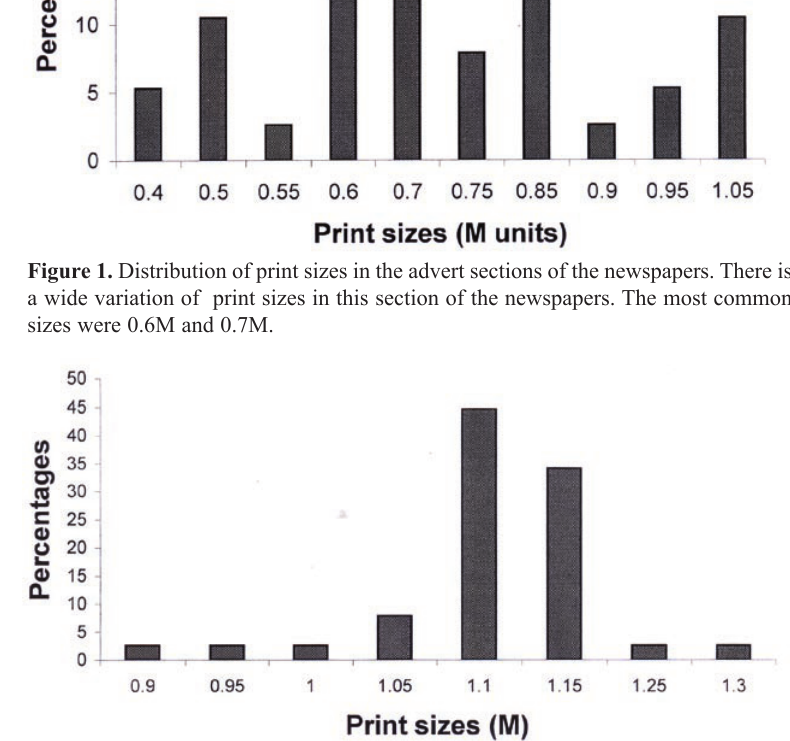
Figure 2. Distribution of print sizes in the news section of the newspapers. Most of the print sizes in this section of the newspaper were between 1.1M and